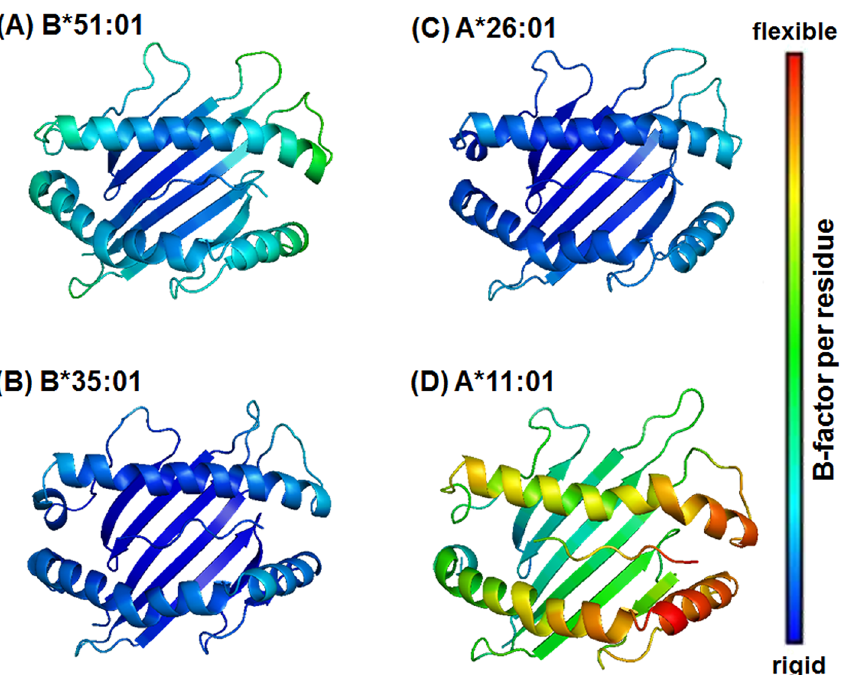
Fig 2. Structural flexibilities of the HLA alleles bound with the MICA-TM peptide. Structural flexibilities were evaluated by B-factor. The ribbon color changes from blue (rigid) to red (flexible) to represent a low to high protein flexibility. Note that for clarity only the binding groove structure and the MICA-TM peptide are